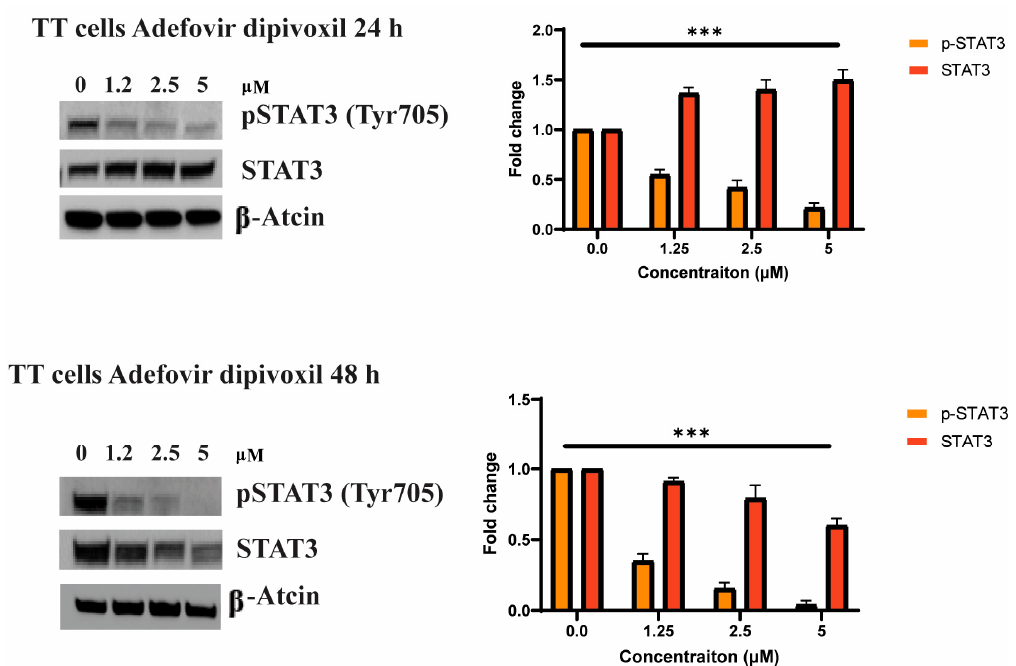
Figure 7. Inhibition of STAT3 tyrosine phosphorylation in TT cells by adefovir dipivoxil. TT cells were treated with various concentrations of adefovir dipivoxil at 24- and 48 h. Cell lysates were subjected to Western blot analysis with anti-phospho-Tyr705 STAT3 (pTyr-STAT3) or anti-STAT3 (STAT3) as indicated. The western blotting results for pSTAT3 and STAT3 were quantified by densitometric analysis with normalization to basal expression, and differences among groups were analyzed using one-way ANOVA ( n = 3; *** p ≤ 0.001). The uncropped blots are shown in Figure S7.